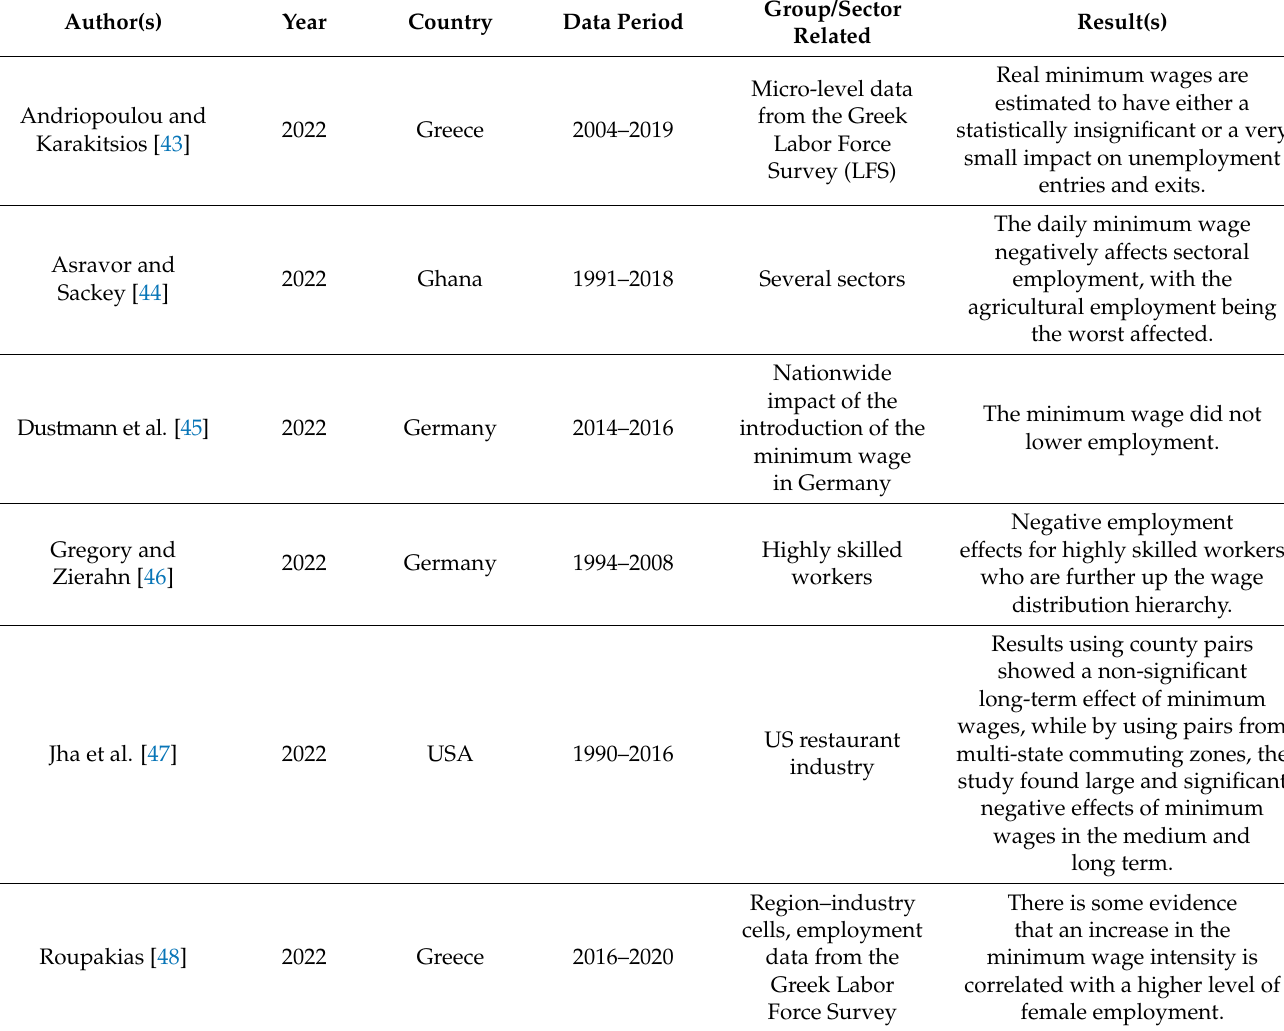
Table 1. Most recent empirical research on the employment effect of minimum